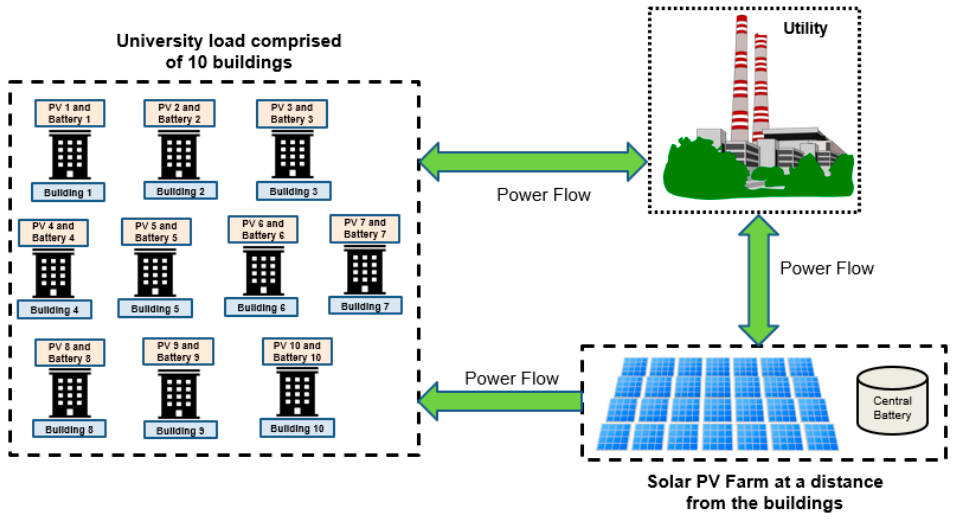
Figure 7. Conceptual design of proposed power system.